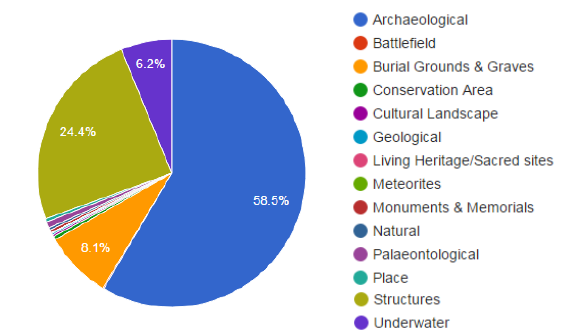
Figure 2: Chart showing the makeup of the inventory of protected sites by site type (SAHRA, 2017).